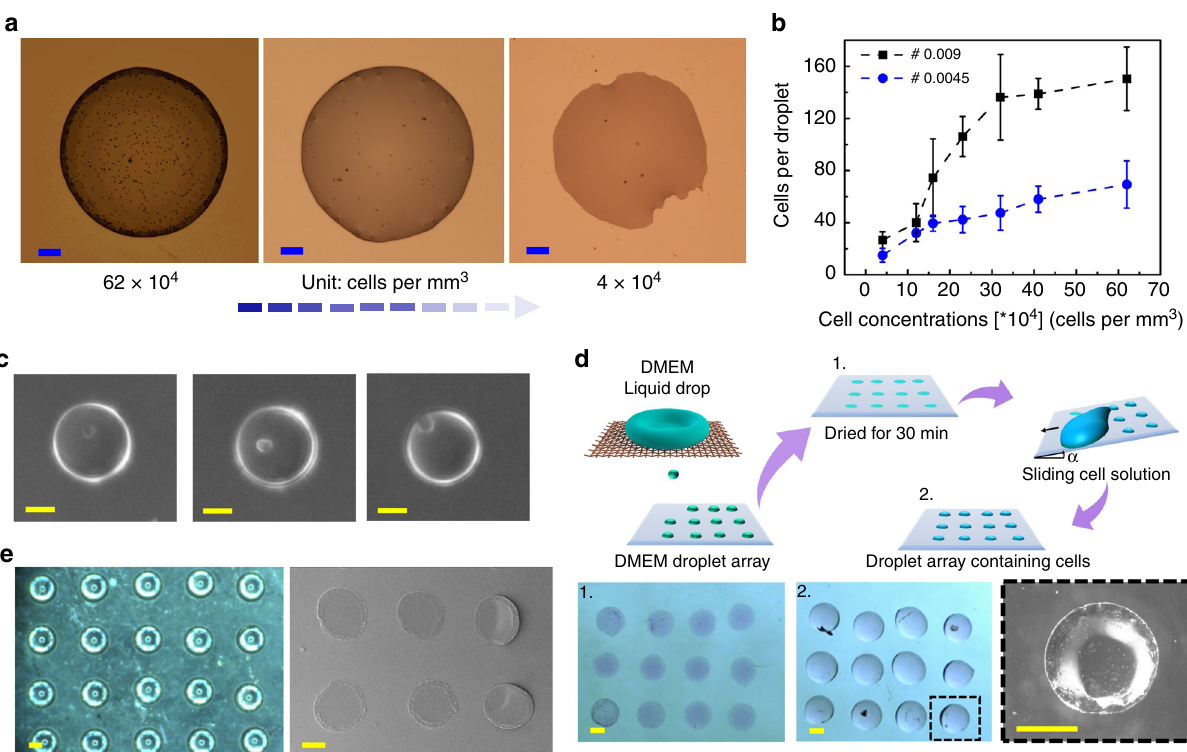
Fig. 4 Drop-impact printing of biological solutions and biopolymers. a Microscopic images of a single droplet patterned using cell (RBC)-laden PBS solution of different concentrations, scale bar: 50 µ m. The cells are contained in an isolated droplet of volume 26 nL patterned using mesh type #0.009. b The number of cells per droplet for varying cell concentrations was examined for mesh types #0.009 and #0.0045. The single-cell printing was further demonstrated using drop-impact technique. c Single cells (MDA-MB-231) of average size ~17 µ m were trapped in a 0.268-nL single drop. The drops were collected on an oil-coated glass slide. The concentration of cell solution was kept at 50 × 10 4 cells per mm 3 (scale bar: 50 µ m). d Illustration showing printed DMEM droplet arrays using drop- impact printing technique. (1) Shows printed DMEM droplets on a hydrophobic Te fl on surface. (2) Shows the arrays of MDA-MB-231 cells containing droplets after cell solution swipe, and a magni fi ed image of a printed droplet containing cells (scale bar: 500 µ m). Beside this, the technique ’ s ability was explored by using biopolymeric viscoelastic liquid (0.0125 g per mL polyacrylic acid mixed in water) for 3D printing applications. e The large patterned microposts of 875 µ m diameter and 2 µ m height were printed on APTES-coated glass slides and the corresponding scanning electron microscopy (SEM) image (scale bar: 400 µ